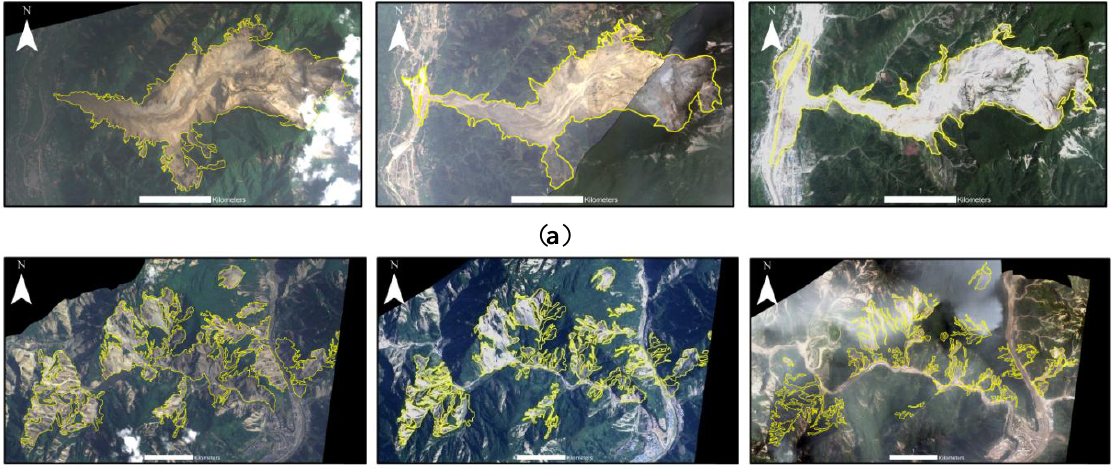
Figure 4. Airborne remote sensing images of several hazards in 2008, 2009, and 2011, respectively (from left to right). ( a ) The big landslide and debris flow of Wenjiagou, Qingping Town, Mianzhu City (site No. 1); ( b ) The big landslide group happened at Yingxiu Town, Wenchuan County (site No. 7); ( c ) The change of hazard happened at Tangjiashan, Beichuan County (site No. 10); ( d ) The change of hazard happened at Changheba, Mianzhu City (site No. 14); ( e ) The change of Daguangbao hazard group, An County (site No.